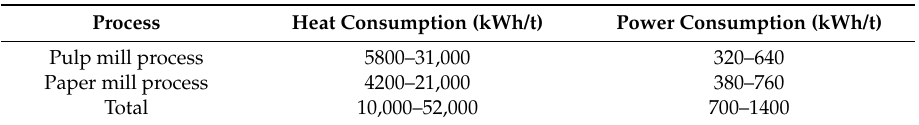
Table 2. Electric and heat specific consumptions of a typical Kraft fully-integrated bark-fired pulp and paper